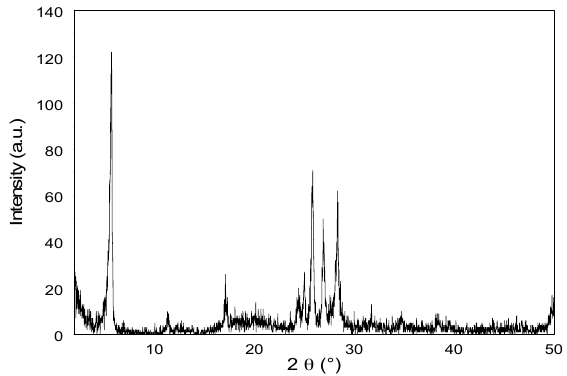
Figure 1. X-ray diffraction pattern of the as-synthesized layered sodium silicate magadiite. SEM image (Figure 2) of SNCM showed well-crystallized rosette-shaped Na–magadiite particles (SEM), with a diameter for the “flower” and “petals” of about 5–7 µm. The single magadiite